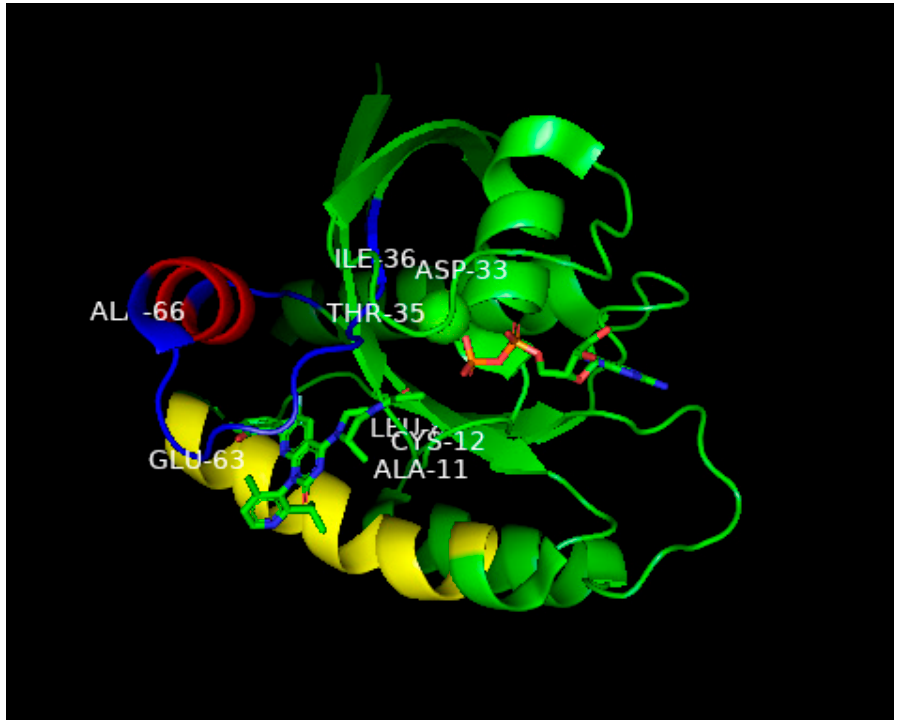
Figure 7. Ribbon representation of the X-ray structure of AMG510 bound to G12C-RAS-p21-GDP from Ref. [36]. Coordinates were obtained from the Protein Data Base (PDB) identity number 7RPZ and rotated to give a clear view of the binding pocket occupied by AMG510. The color scheme for critical domains is the same as for Figure 5. G12C-RAS-p21 uniquely has a groove formed by the switch 2 domain, consisting of residues 55–76 (colored blue except for its α 2 helix that is colored red) and its α 3 helix (residues 89–103, colored yellow). The orientation of this complex is similar to that of the KD2-G12D-RAS-p21-GppNHp complex shown in Figure 5. As in Figure 5, the nucleotide (here, GDP) is oriented horizontally such that the guanine ring is on the far right in the middle of the figure, and a β -phosphate oxygen binds to the magnesium ion (green sphere in the middle of the figure). The AMG510 molecule can be seen in the lower left of the protein inserted into a groove between the yellow α 3 helix and the blue switch 2 loop region above it in the figure. Just above Leu 80 (“Leu” in the middle of the figure), there is a red projection that is the carbonyl oxygen of the acryl moiety of the drug that is positioned to react with the-SH group of Cys 12 labeled in the figure. In contrast to Figure 5, the switch 1 domain is seen to be well-defined and can be identified by the labeled residue positions Asp 33, Thr 35 and Leu 36. Unlike the positioning of switch 1 residues on the surface of the protein in Figure 5, the switch 1 residues of G12C-RAS-p21-GDP are not as exposed.